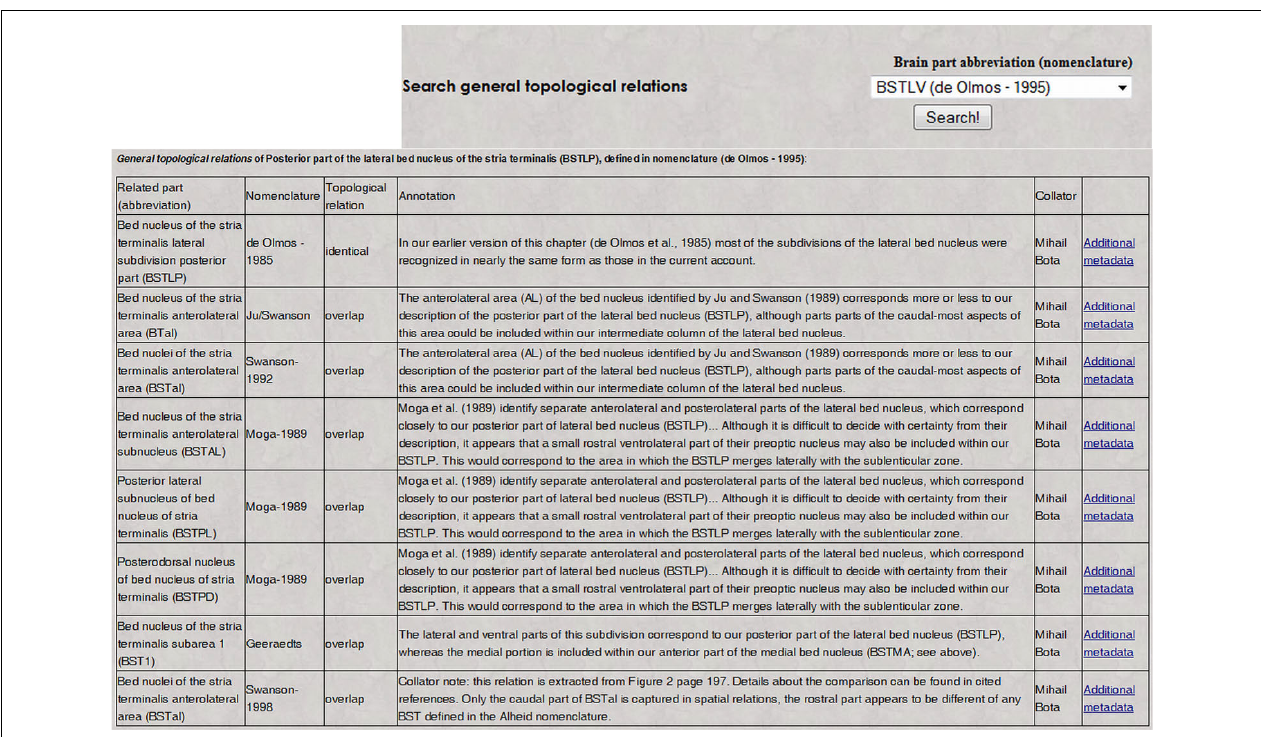
FIGURE 2 | The result of a search in BAMS for topological relations by regions defi ned in different neuroanatomical nomenclatures (inset; it can be accessed directly at the URL: http://brancusi.usc.edu/bkms/brain/search_bname_con.